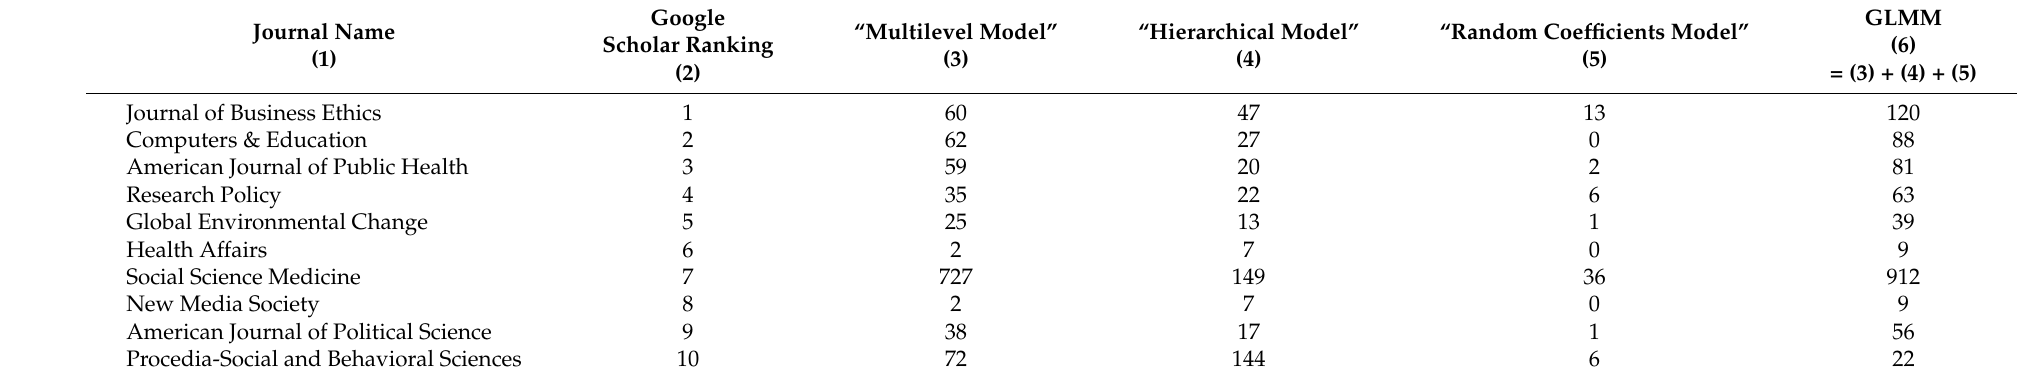
Table 2. Use of GLMM in the top 10 journals in the field of Social